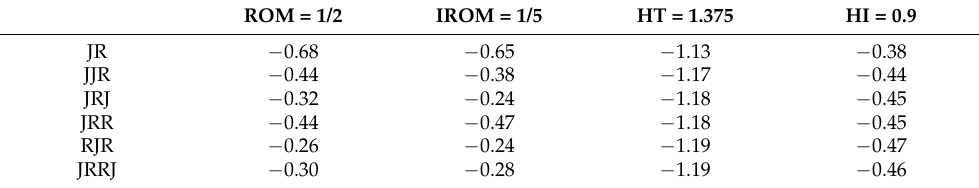
Table 9. Correlation between modified micromechanical data with experimental data for hybrid composite. ROM = 1/2 IROM = 1/5 HT = 1.375 HI = 0.9 JR − 0.68 −